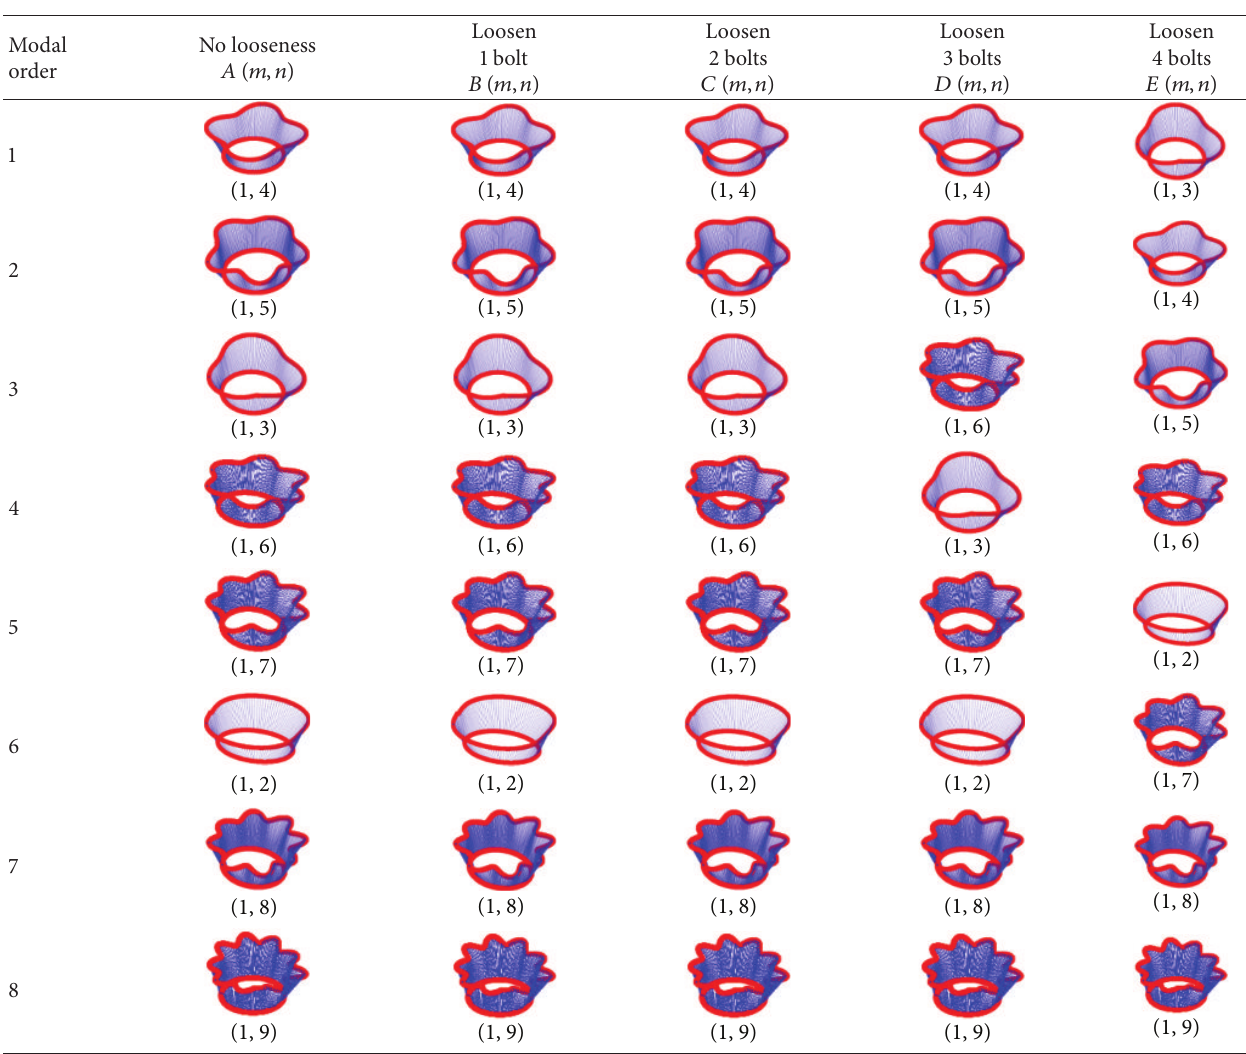
Table 9: Mode shapes of TCS under BLB with different looseness